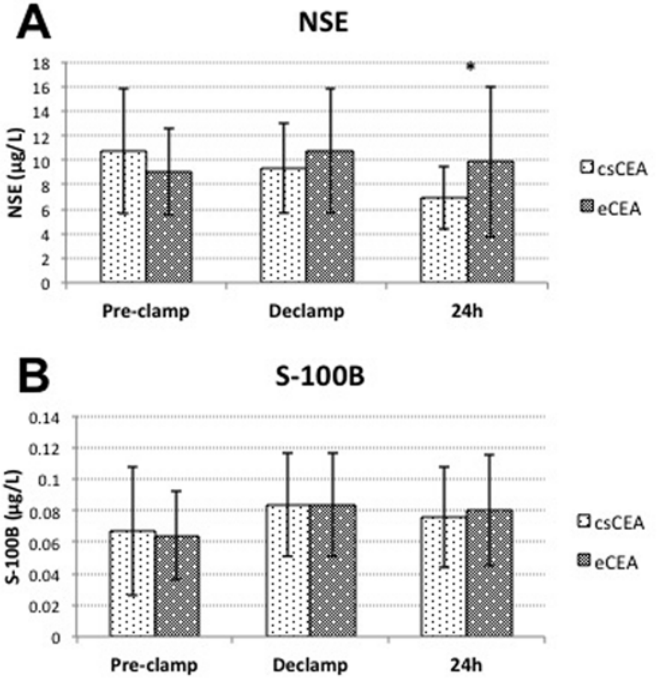
Fig 3. Variations of NSE and protein S-100B serum concentrations between groups. (A) variations of NSE concentrations; (B) variations of protein S-100B concentrations; * — P < 0.01